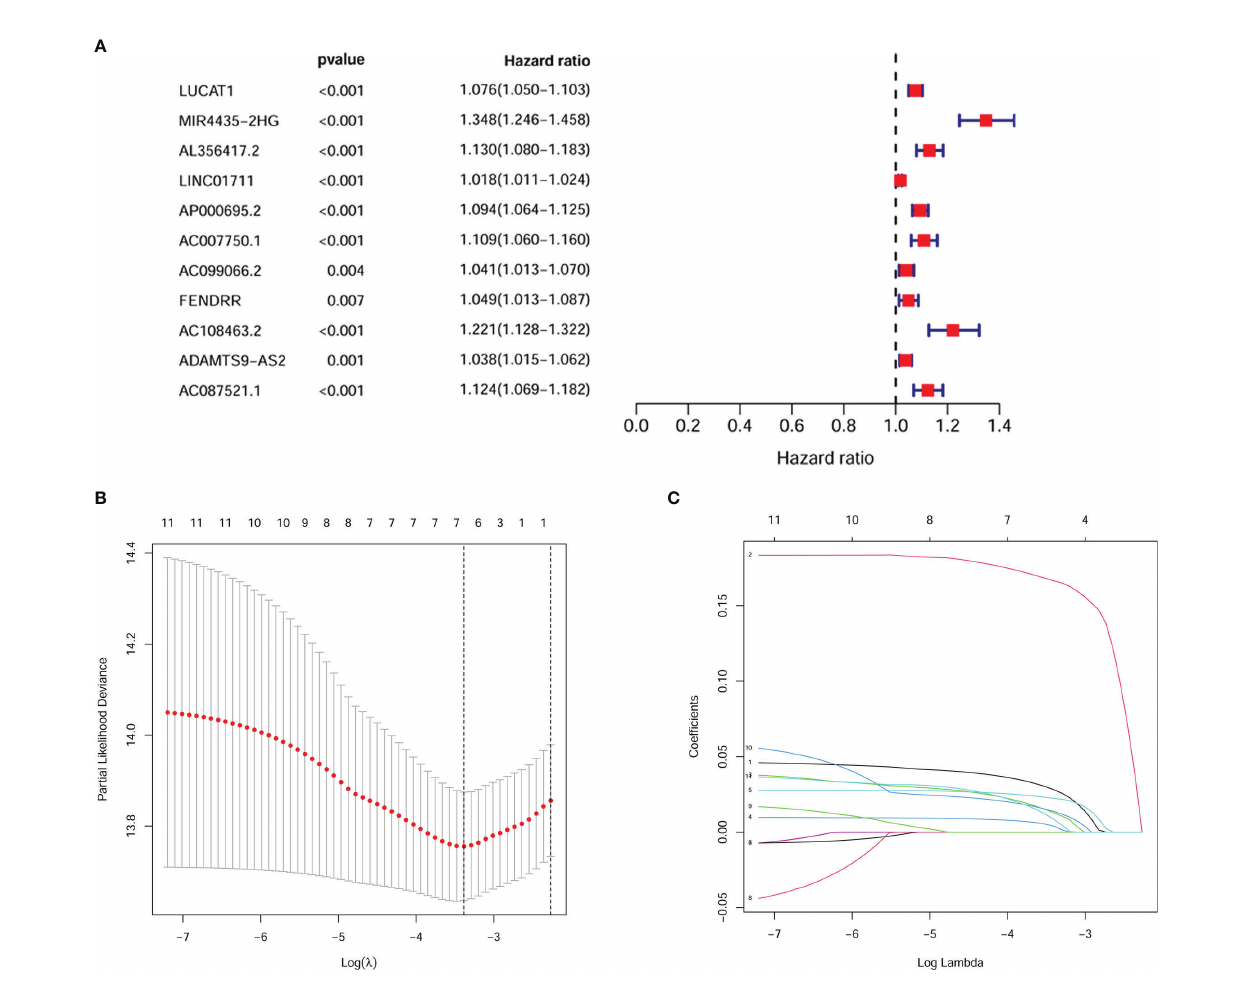
FIGURE 2 | Screening for pivotal HRlncRNAs. (A) 11 HRlncRNAs were derived by univariate cox analysis. (B, C) It predicted the optimal model using Lasso regression analysis.